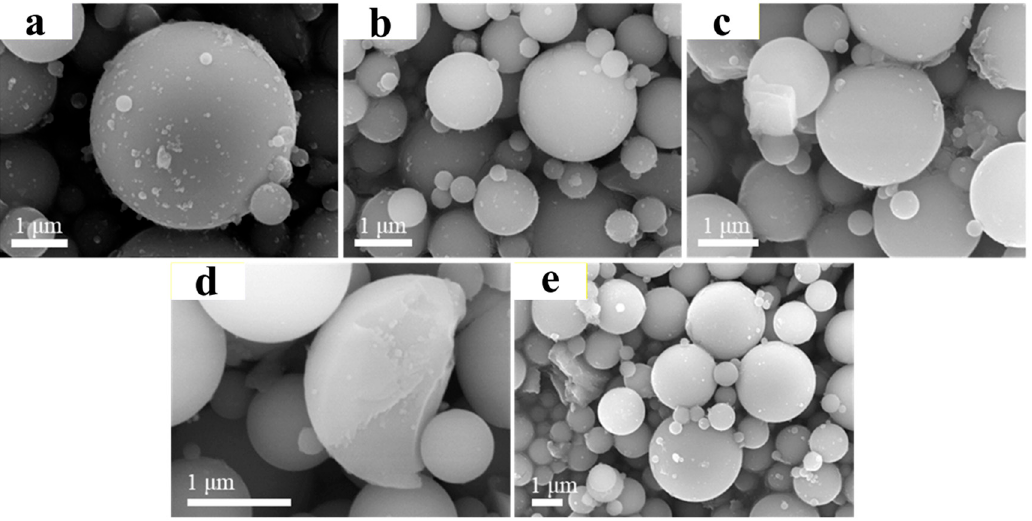
Figure 1. SEM images of ( a ) 0-SiO 2 -M, ( b ) 0.2-SiO 2 -M, ( c ) 0.4-SiO 2 -M, ( d ) 0.6-SiO 2 -M, and ( e ) 1.0-SiO 2 -M, respectively.